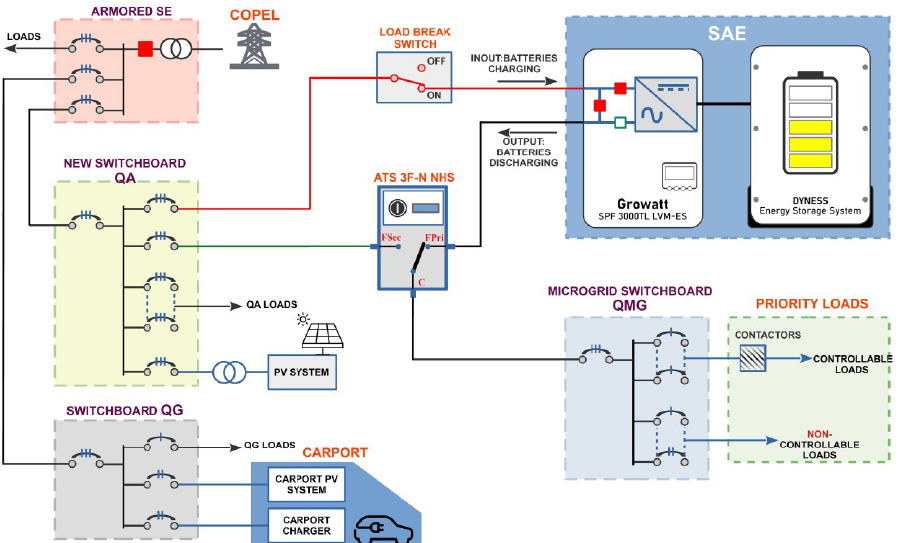
Figure 4. Schematic diagram of the IMAP–Barigui microgrid.